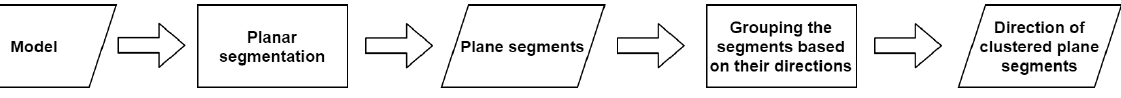
Figure 2. Workflow for determining the directions of clustered plane segments .